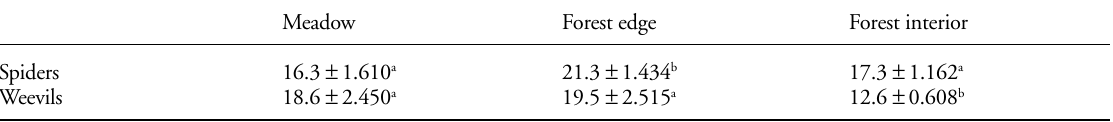
Table 1. Species richness of spiders and weevils in the studied habitats based on sub-samples of 70 individuals. Different letters indicate significant differences (p<0.05). Meadow Forest edge Forest interior